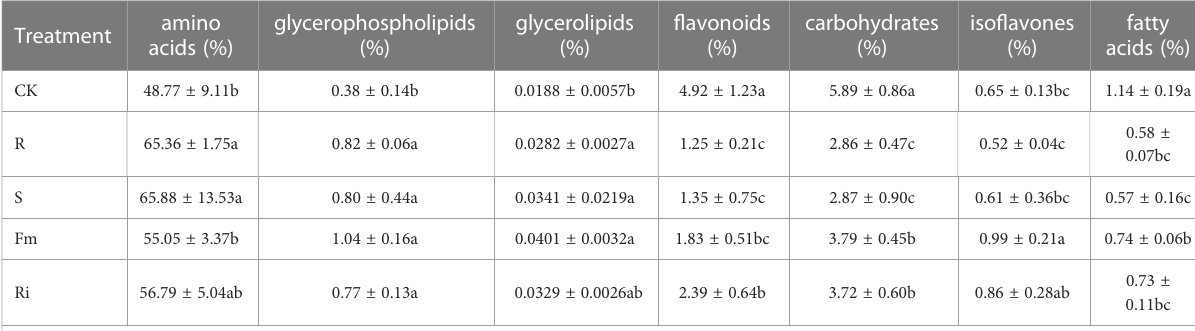
TABLE 4 The relative abundance of metabolite on root of Pyrus betulaefolia .